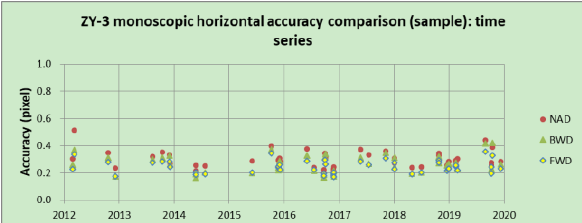
Figure 11. ZY-3 monoscopic horizontal accuracy comparison (sample). Num=47 images; Average errors (sample) of NAD, BWD and FWD are 0.297, 0.262 and 0.243 pixels.